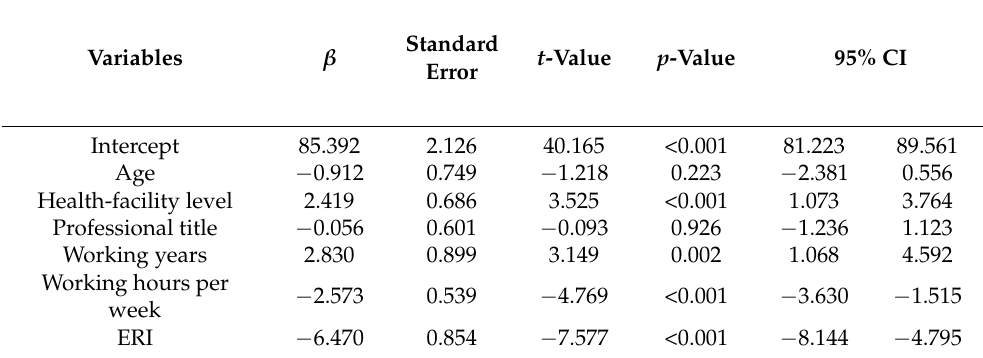
Table 8. Exploration of factors influencing the social health of medical